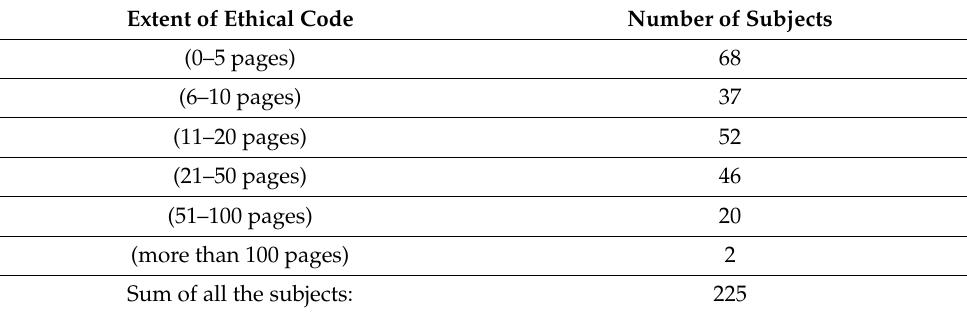
Table 2. Structure of the sample’s extent of ethical code.